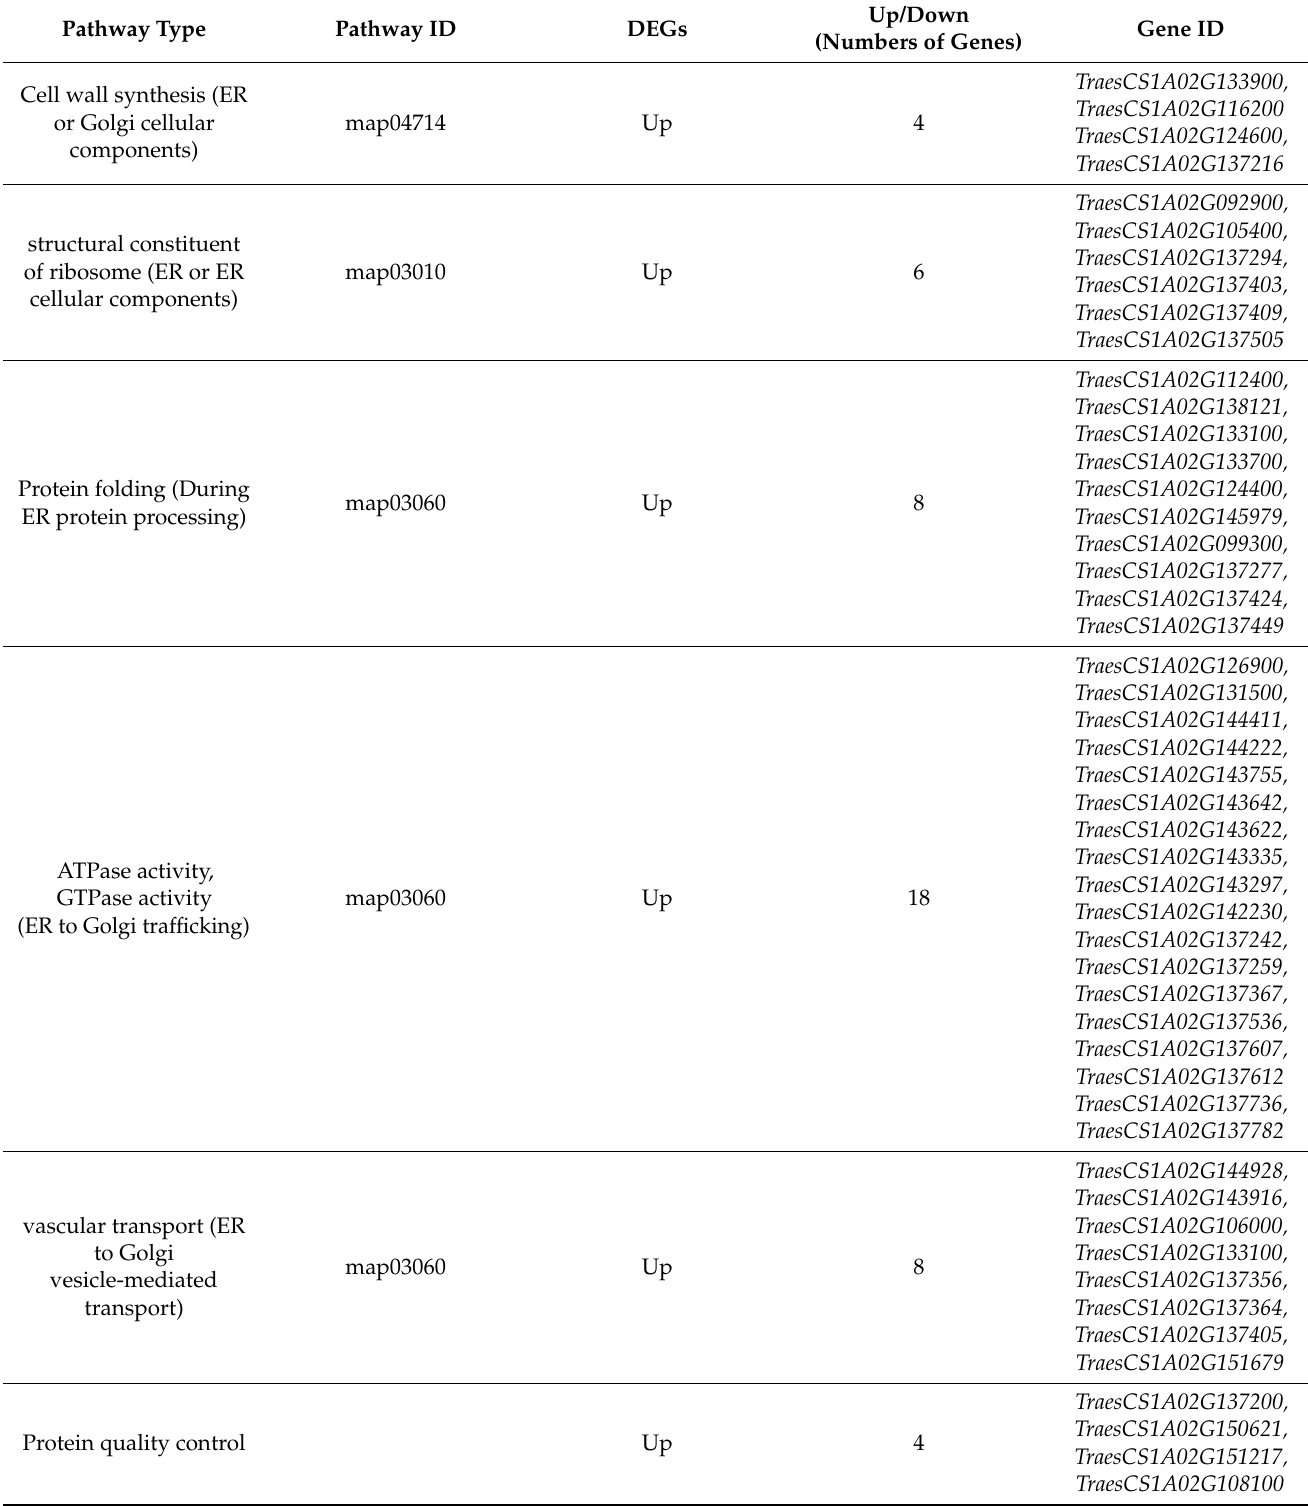
Table 3. Summary of DEGs related to ER protein quality control pathways based on the KEGG database of developing grain at all selected